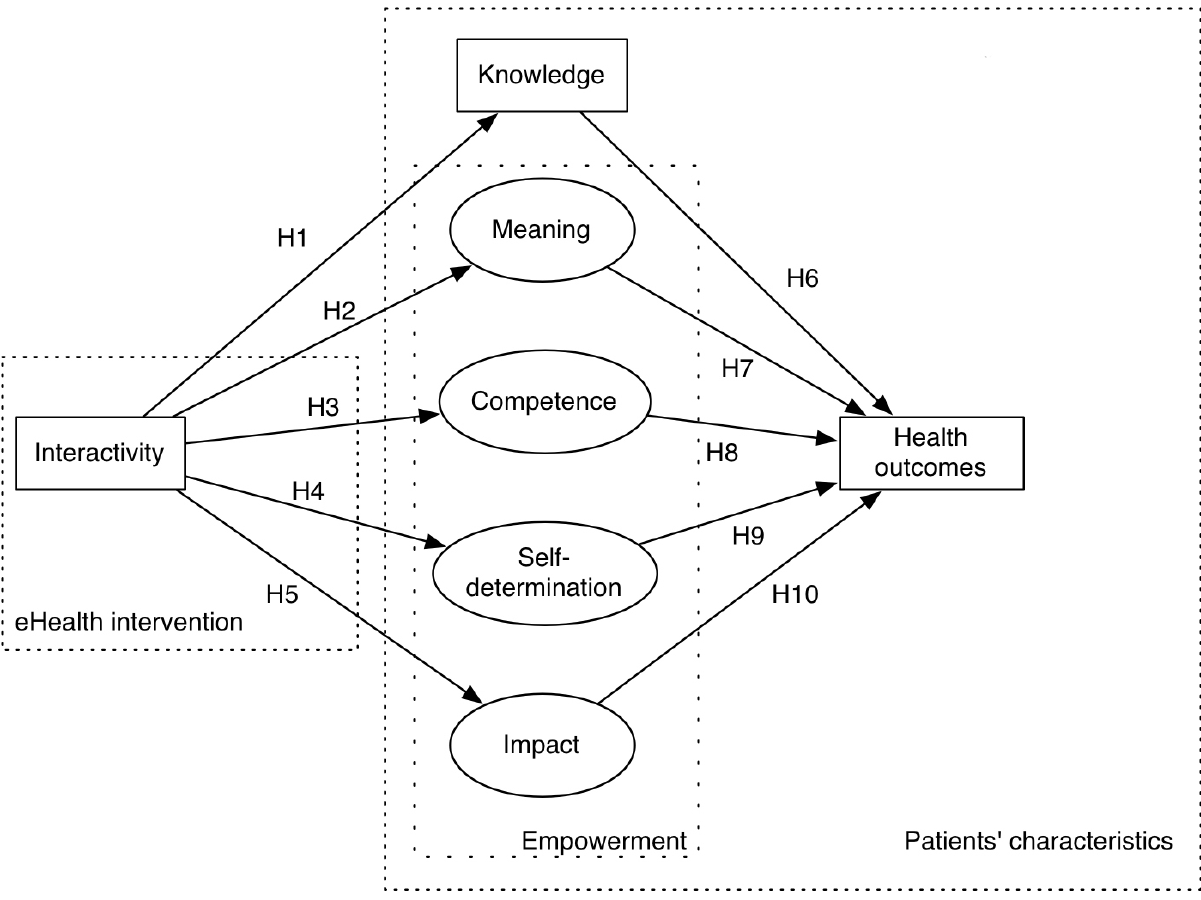
Figure 1. A model of functional interactivity effects on knowledge, empowerment, and health outcomes. Arrows indicate directional effects. H1-H10 = main